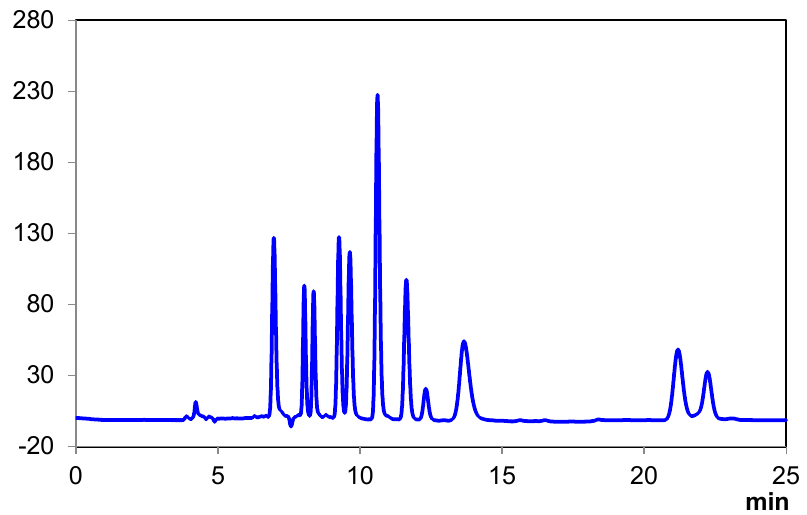
Figure 3. Ten-cannabinoid mixture separation under normal-phase conditions with Chiralpak IH-U.